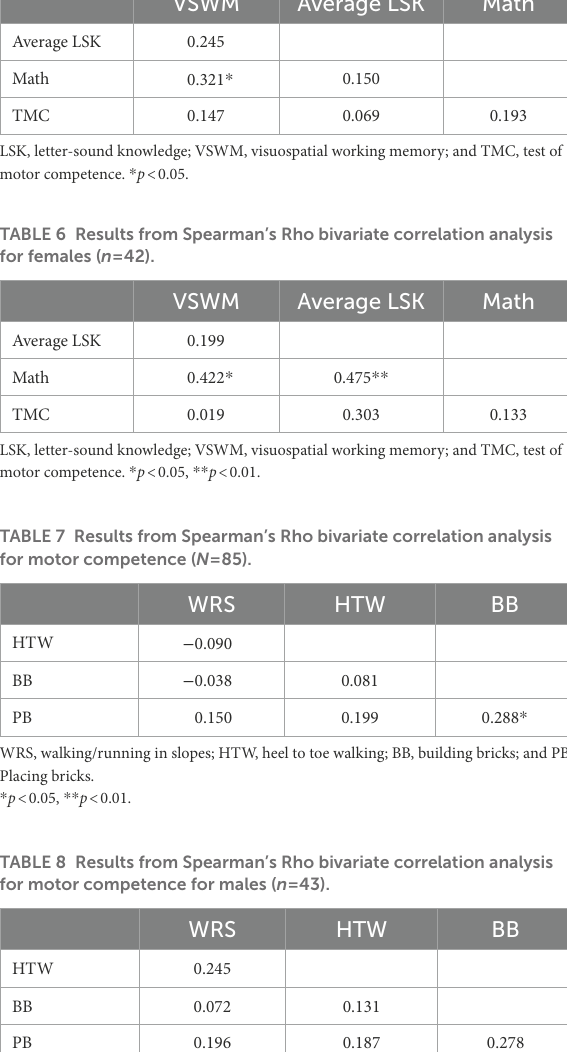
TABLE 5 Results from Spearman’s Rho bivariate correlation analysis for males ( n = 43). VSWM